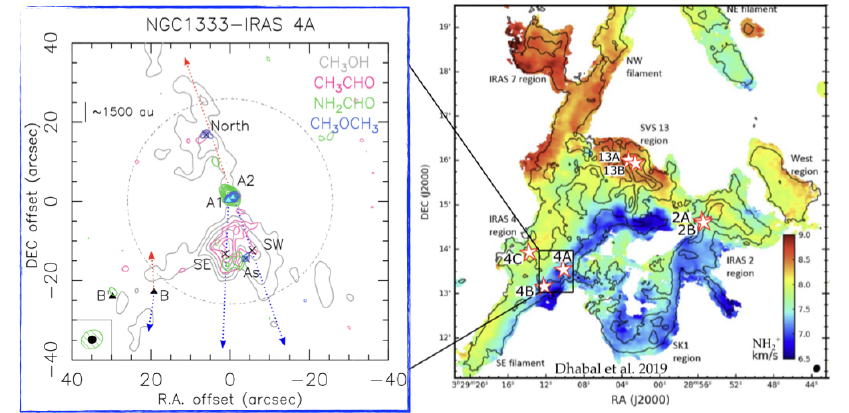
Figure 1. Right : N 2 H + (1-0) velocity map of NGC 1333 south [3]. The main protostellar cores are marked with white stars. Left : iCOMs contour emission in the IRAS 4A outflows observed with NOEMA / SOLIS Observations [4]. The dashed blue and red arrows indicate the direction of outflows. Figure 2.